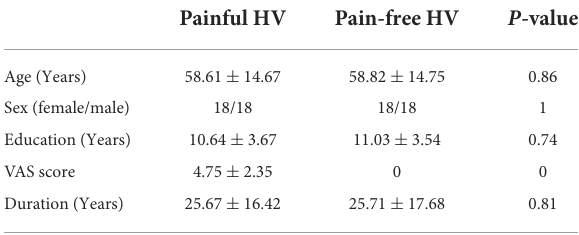
TABLE 1 Demographic data of painful and pain-free hallux valgus